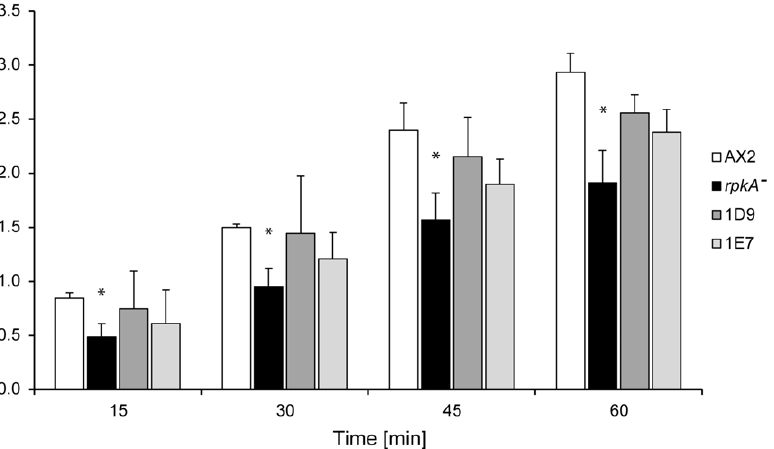
Figure 3. Phagocytosis of yeast cells. AX2 , rpkA 2 cells, and rpkA 2 rescue strains 1D9 and 1E7 expressing RpkA-HA were incubated with TRITC- labeled yeast cells and fixed at the indicated time points. The number of phagocytosed yeast particles per cell was quantified at the indicated time points. Results are provided for three independent experiments 6 SE, *P , 0.05. doi:10.1371/journal.pone.0027311.g003 PLoS ONE |